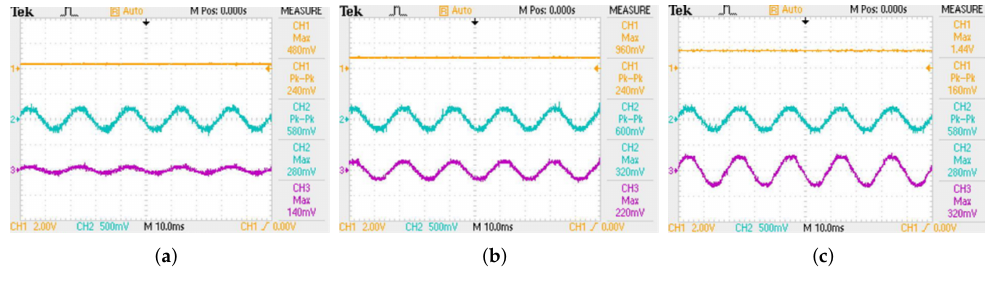
Figure 24. k, irs(ref) and k* irs(ref) currents ( a ) at 0.35, ( b ) at 0.85, and ( c ) at 1.34.